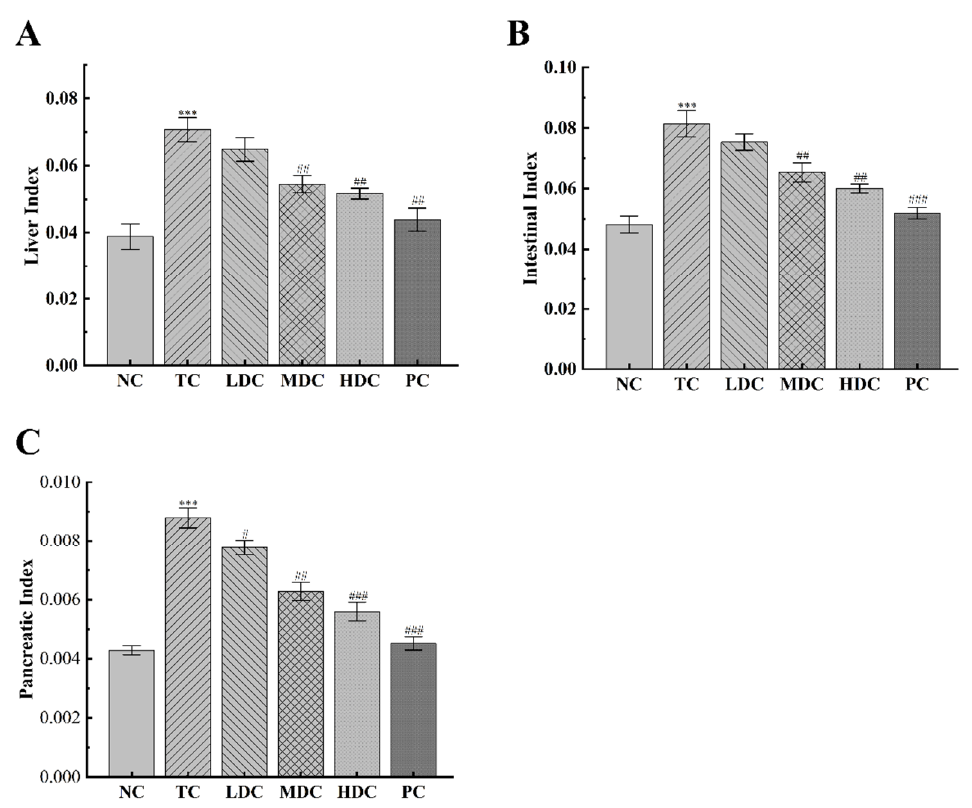
Figure 1. Effect of PSS on organ index. ( A ) The liver index. ( B ) The intestinal index. ( C ) The pancre- atic index. The organ index was calculated by dividing the organ weight by the body weight. Data are presented as mean ± SD (n = 8); *** p < 0.001 compared to the NC group; # p < 0.05, ## p < 0.01, and ### p < 0.001 compared to the TC group.